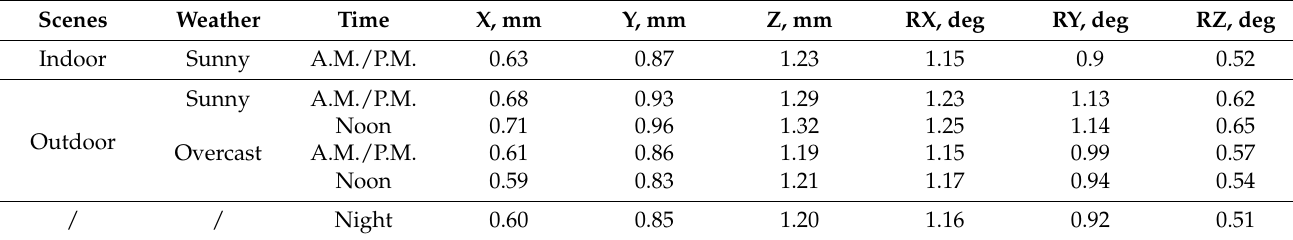
Table 7. LP error in PPS.